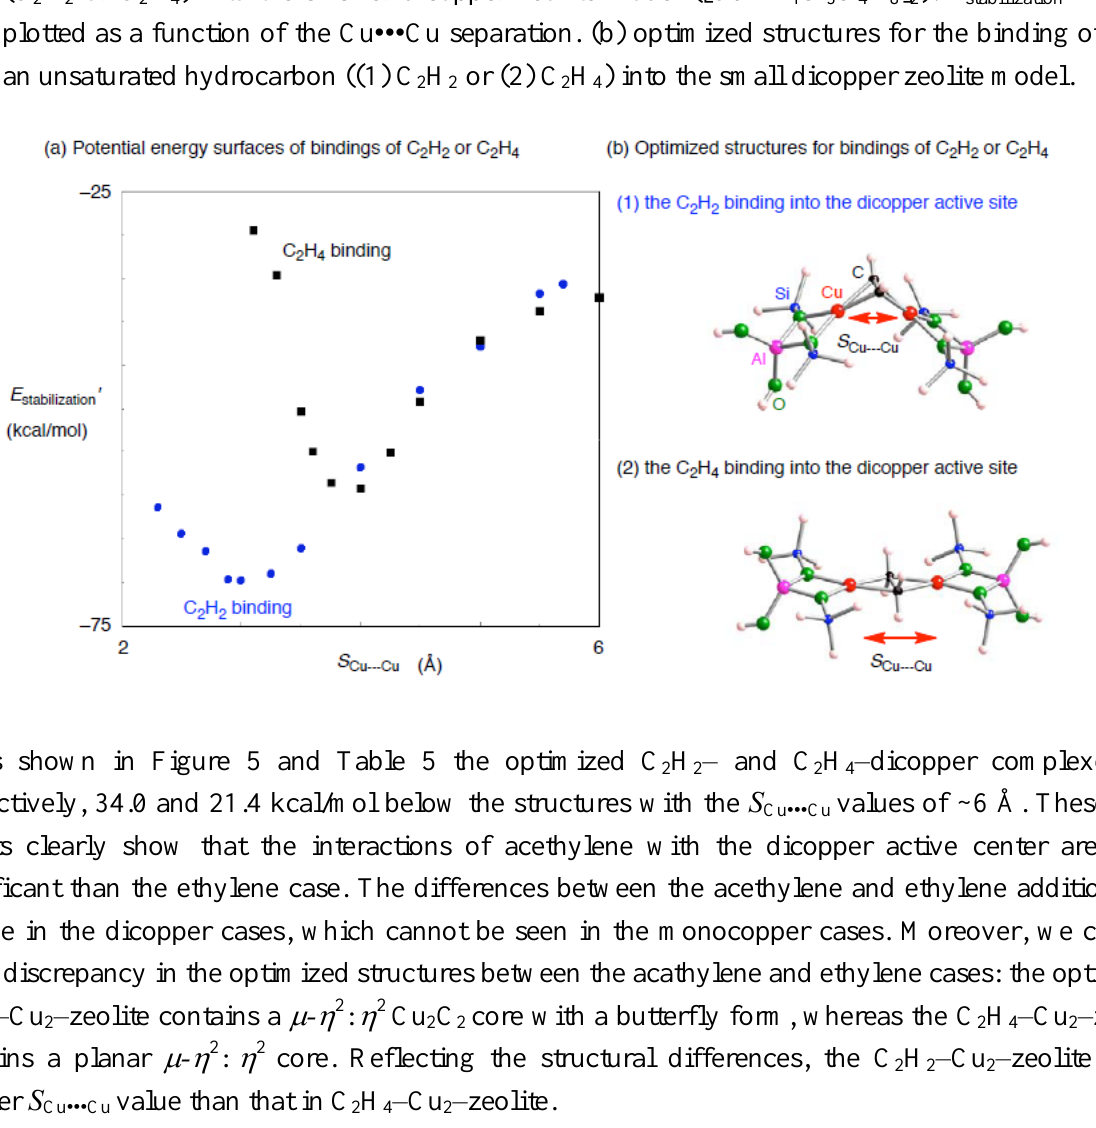
Si O H ] ). E ’ is 1 3 4 8 2 stabilization